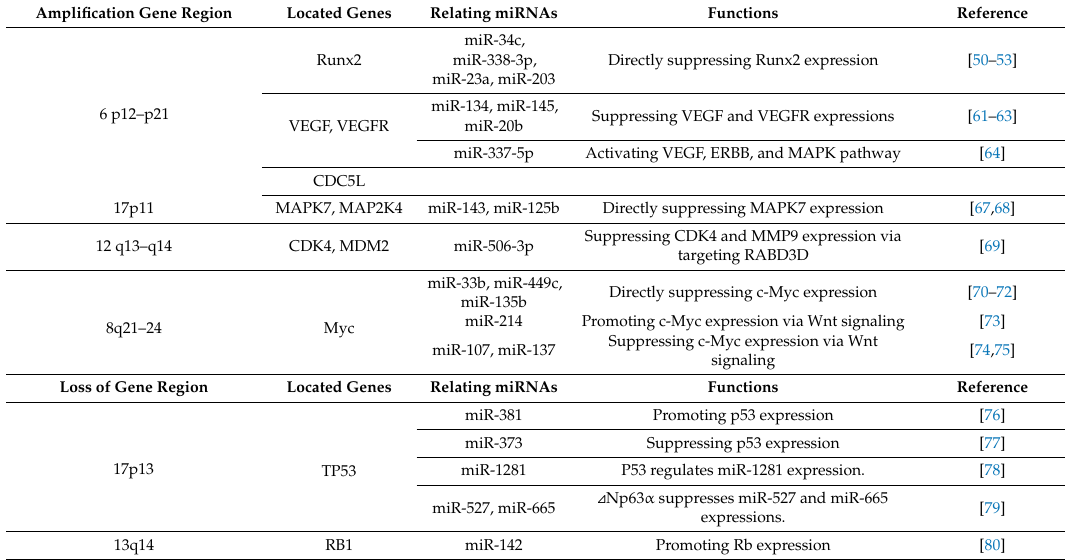
Table 1. The gene amplification regions of Osteosarcoma and relating genes and miRNAs.